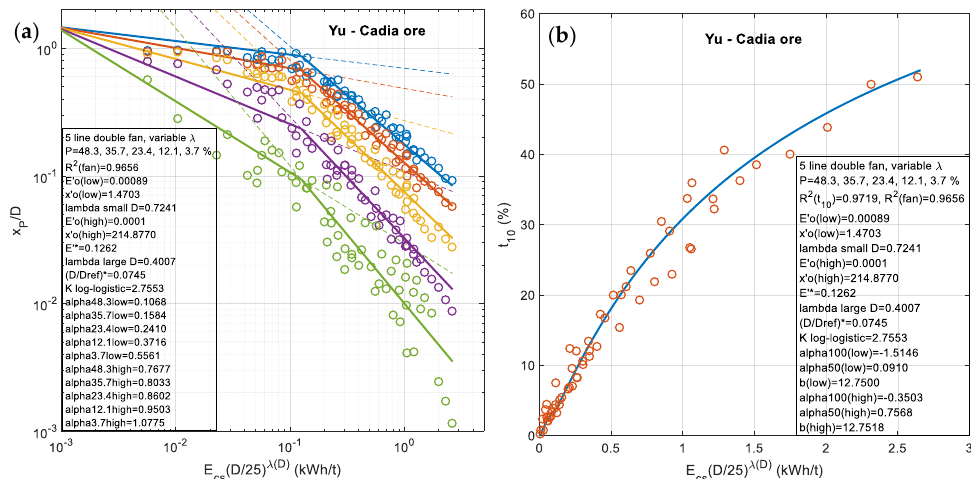
Figure 13. Improved double fan (basic fan with I-4) for Cadia ore ( a ) and corresponding BIE ( b ), R 2 = 0.9719).